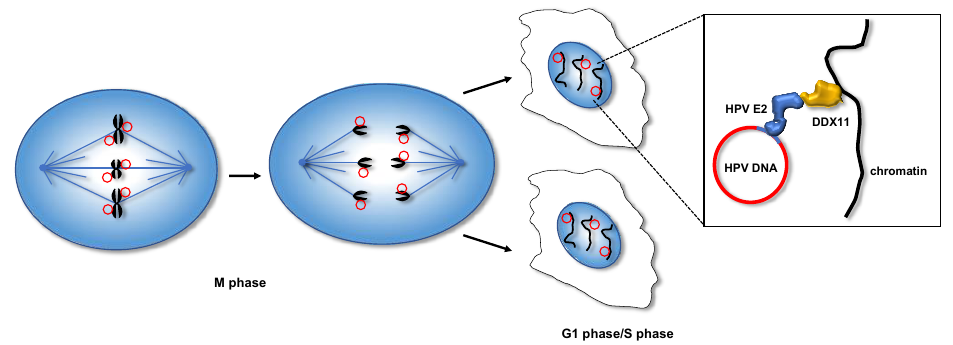
Figure 3. Human papillomavirus (HPV) genome replication and maintenance in infected host cells. The episomal viral DNA molecules (red circles) are tethered to the host cell chromatin throughout the cell cycle. This mechanism enables an even distribution of the viral genomes between the daughter cells, thus ensuring a persistent viral infection. In the inset, the protein bridge made of HPV E2 bound to DDX11 needed for tethering viral DNA to host cell chromatin during S phase is schematically depicted (see text for details).